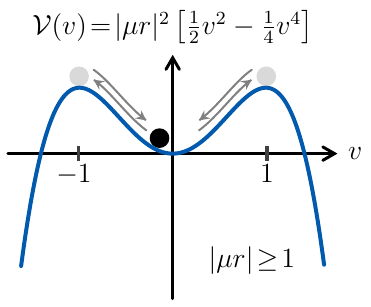
Figure 2 . Sketch of the potential and the reversed motion applies for (cid:25)= 2 < ’ VEV Georgi et al.’s approximate solution